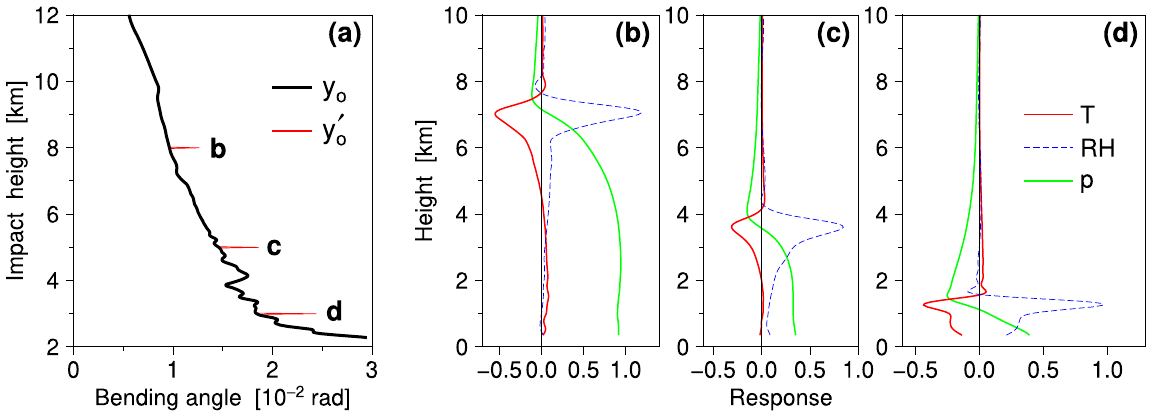
Figure 4. 1D-Var response to a bending angle profile perturbated at single levels. ( a ) Impulse perturbations (red horizontal lines, marked b–c) added to an observed COSMIC profile of the bending angle (heavy black line) at the impact heights of 3, 5, and 8 km. ( b ) The 1D-Var response to the 8 km perturbation in temperature (red line; °C), relative humidity (blue dashed; 0.2 by fraction), and pressure (green; 0.2 hPa). ( c , d ) are same as in ( b ) but for the perturbations at the impact heights of 5 and 3 km, respectively. Note that the responses are shown as functions of the height.